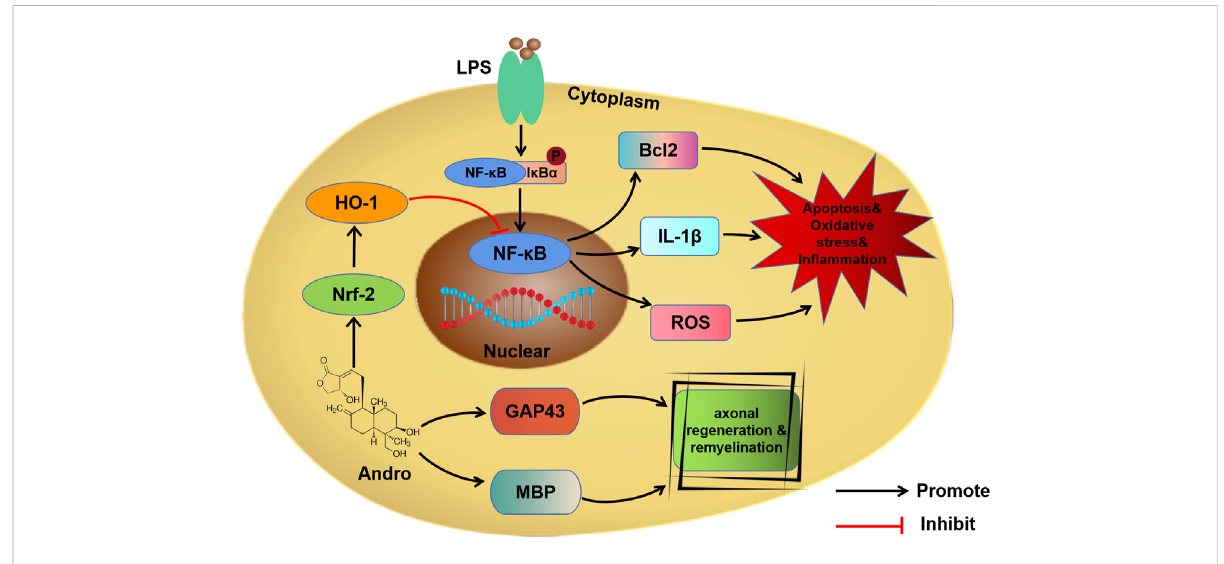
FIGURE 8 Schematic diagram showing the mechanism of